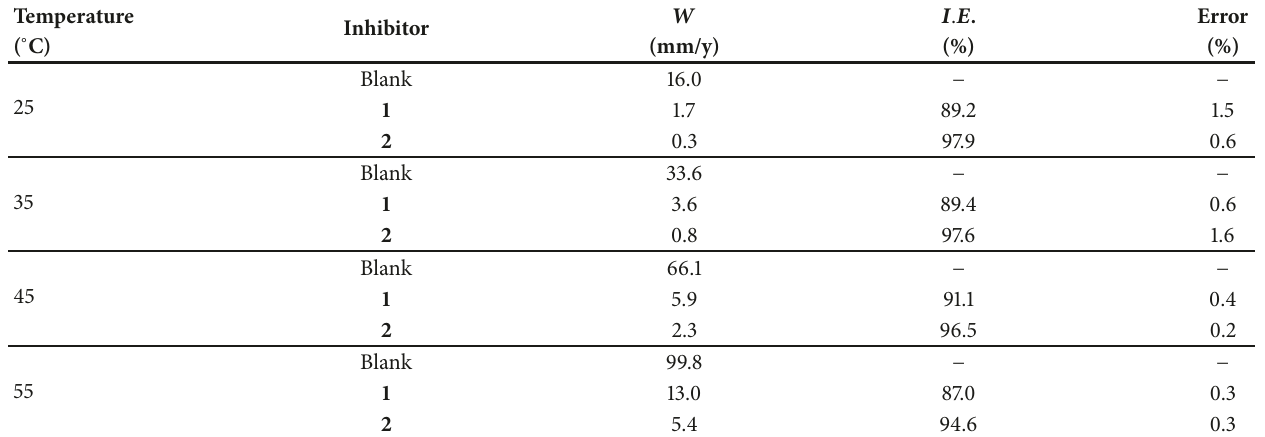
Table 5: Inhibitor efficiencies and corrosion rates to carbon steel in 1.0 mol L – 1 HCl aqueous solution in absence and presence of 250mg L – 1